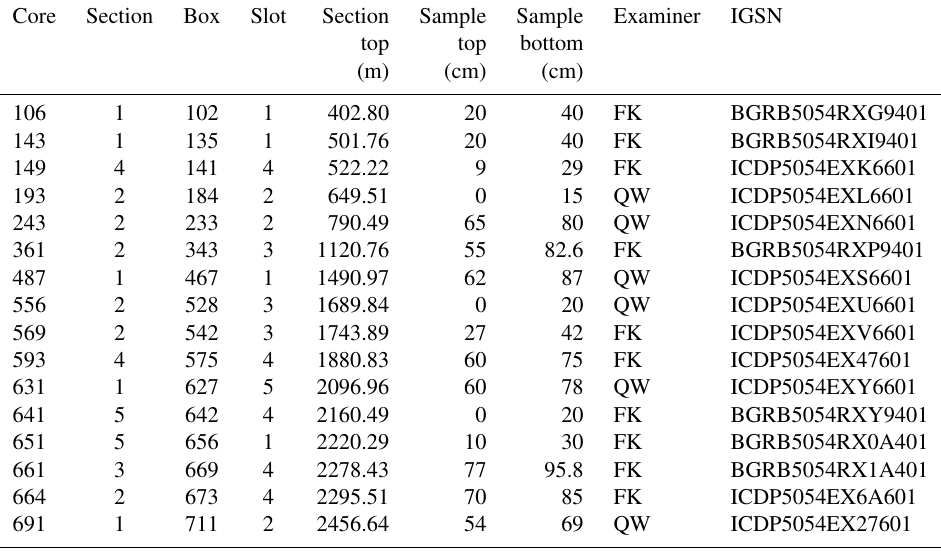
Table A1. List of investigated core samples, their exact core position, and associated International Geo Sampling Number (IGSN). The section tops refer to the meter-corrected depth from the operation data sets (Lorenz et al., 2019). FK – samples newly measured for this study; QW – samples originally measured by Wenning et al.